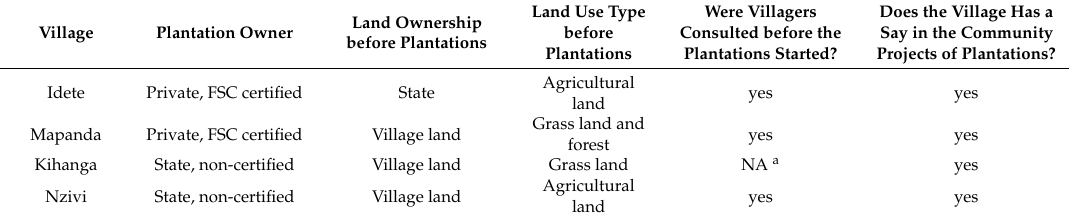
Table 4. Community Perceptions about Participation, Pre-plantation Land Use and Tenure